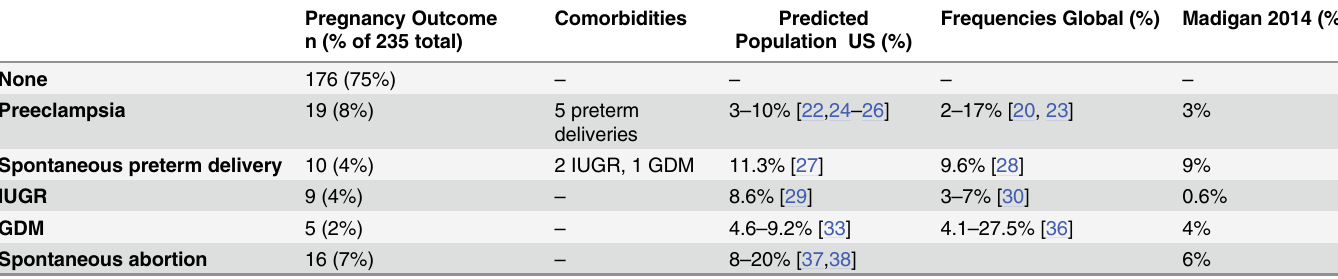
Table 1. Frequency of clinical outcomes compared to national and global